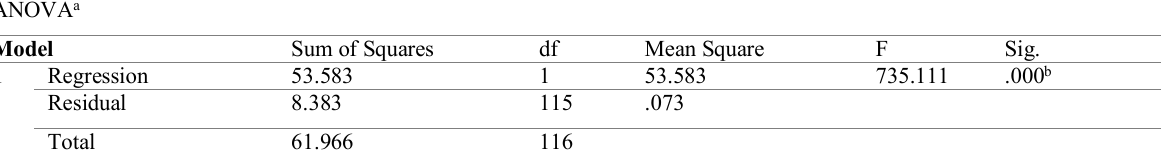
Table 10: Regression ANOVA for participative leadership style